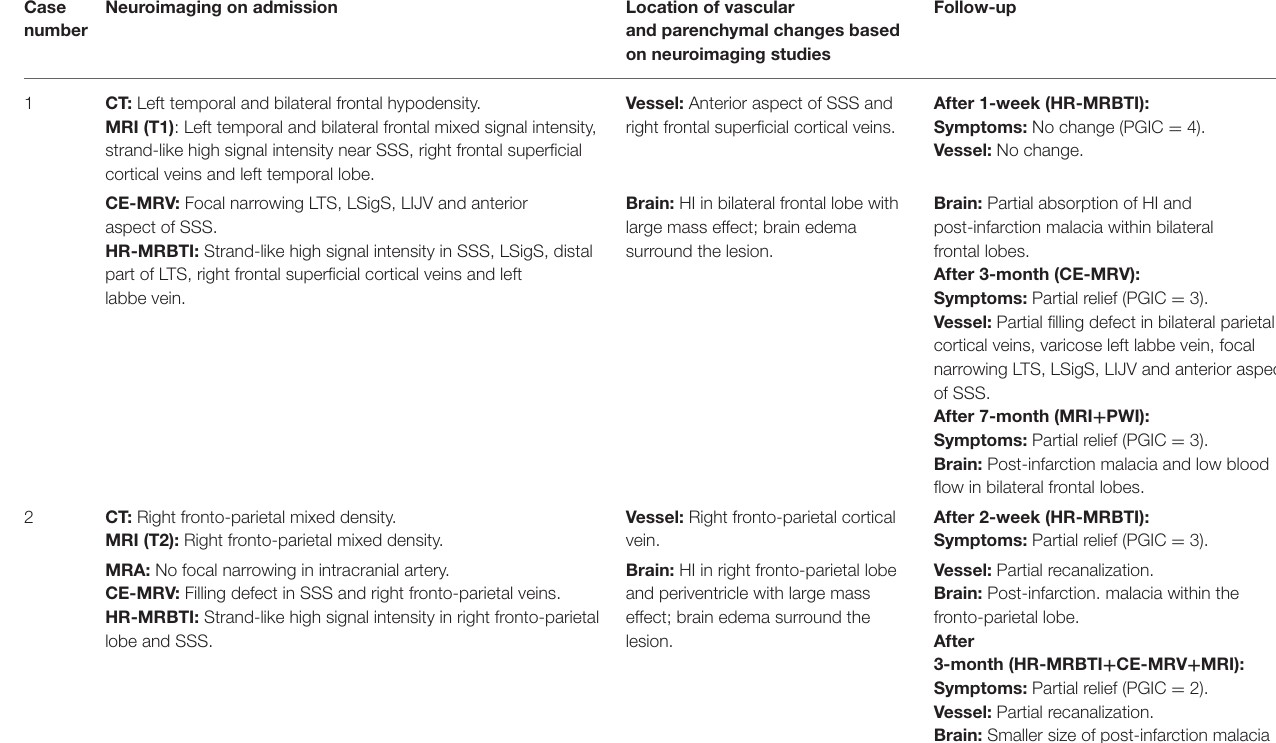
TABLE 2 | Neuroimaging patterns of the patients with CCVT on admission and follow-up. Case Neuroimaging on admission Location of vascular number